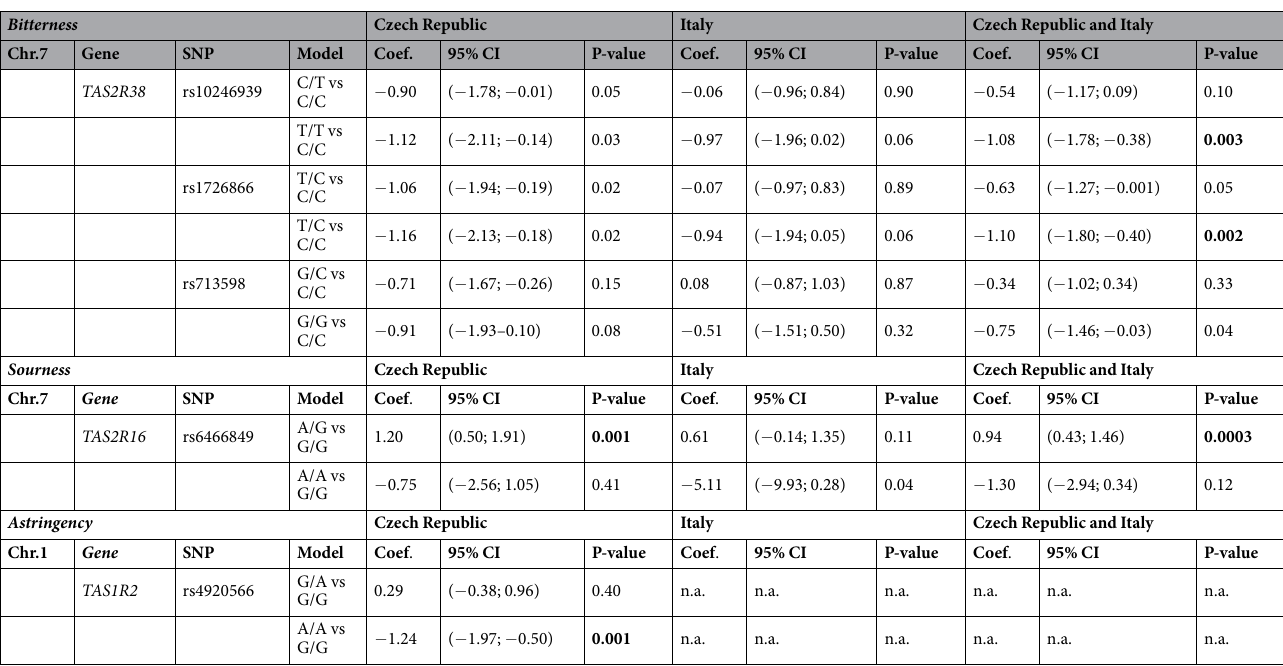
Table 3. Statistically significant associations between TAS genes polymorphisms and wine